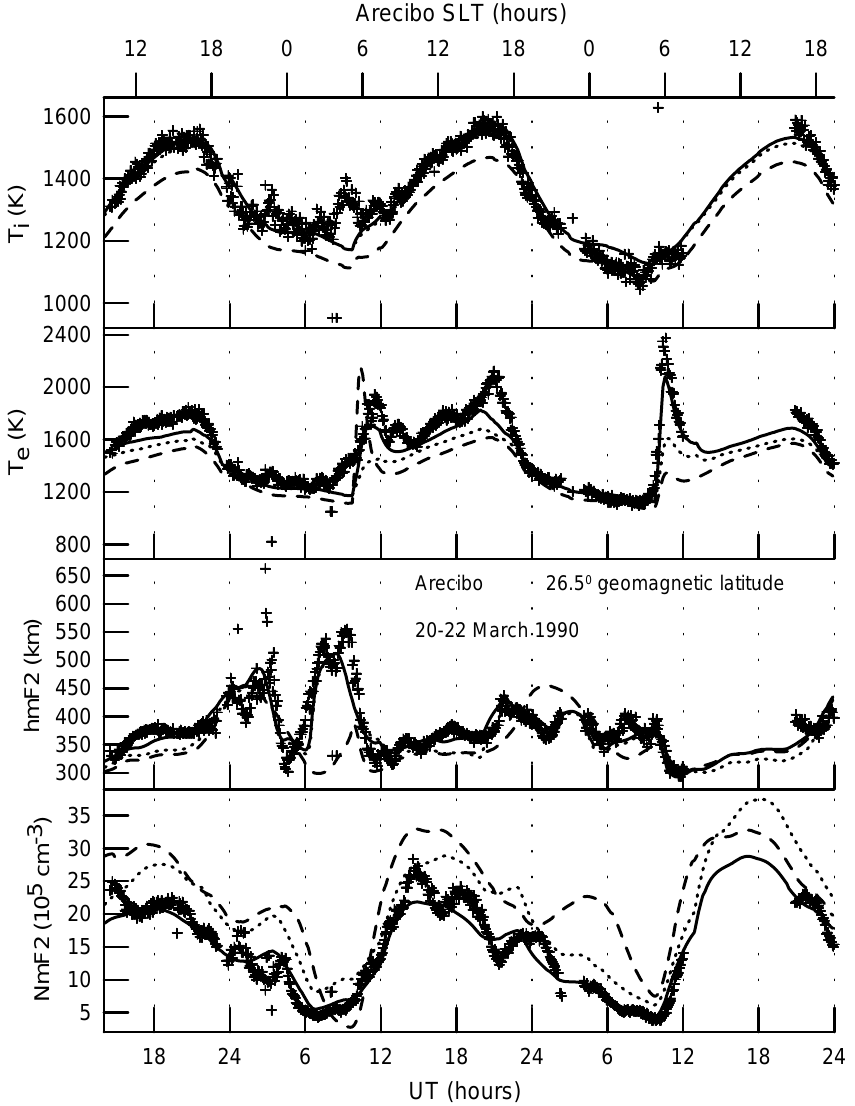
Fig. 12. Observed (crosses) and calculated (lines) Nm F2 and hm F2 (two lower panels), and electron and O + ion temperatures (two upper panels) at the F2-region main peak altitude above the Arecibo radar during 20–22 March 1990. SLT is the solar local time at the Arecibo radar. The results obtained from the model of the ionosphere and plasmasphere, using the original NRLMSISE-00 neutral temperature and densities and the original HWM90 wind as the input model parameters, are shown by dashed lines. Solid lines show the results produced by the model of the ionosphere and plasmasphere, using the corrected NRLMSISE-00 neutral temperature and densities, and the corrected meridional HWM90 wind (see Sect. 4.2). Dotted lines show the results from the model with the same values of the HWM90 wind and the NRLMSISE-00 neutral temperature and densities, as for solid lines, when vibrationally excited N 2 and O 2 are not included in the loss rate of O + ( 4 S)